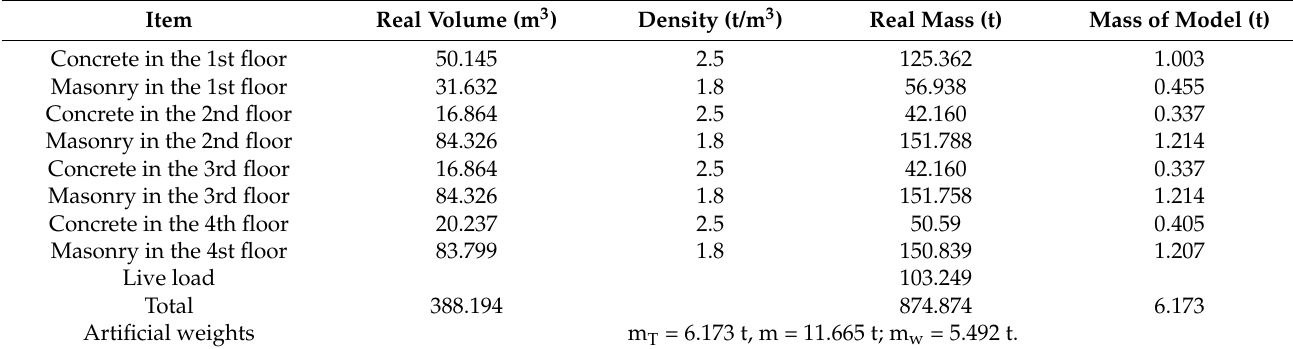
Table 2. The similarity of physical parameters.